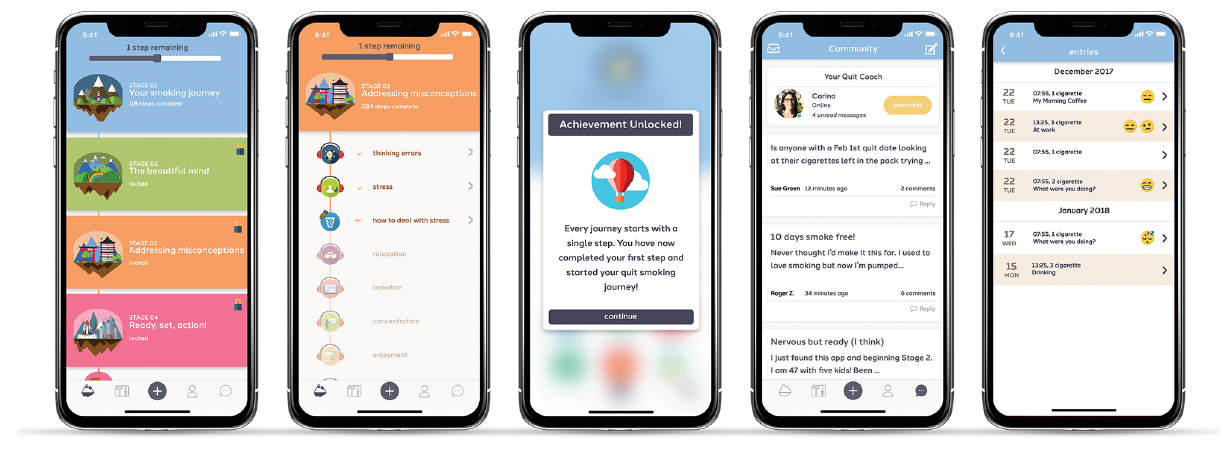
Figure 2. Screenshots of Quit Genius app.